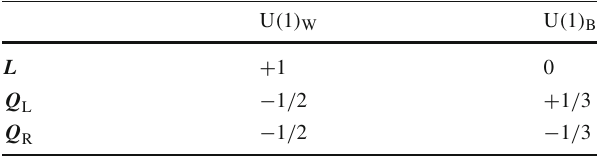
Table 2 Charge assignment of the light bi-triplets in the trinification theory under the accidental symmetries of the superpotential Eq. (2.18). The family index is implicit